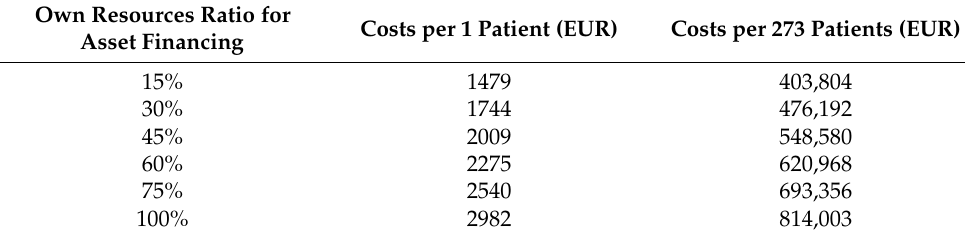
Table 16. Sensitivity analysis on changes to depreciated amounts included in ABC costing—IMRT Own Resources Ratio